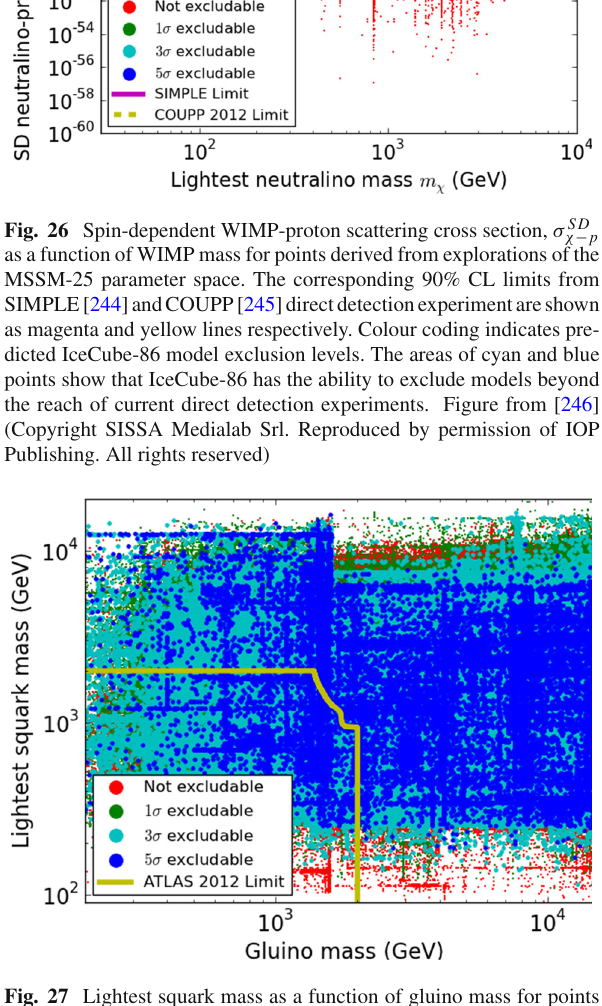
Fig. 27 Lightest squark mass as a function of gluino mass for points derivedfromexplorationsoftheMSSM-25parameterspace.Thepoints to the bottom left of the magenta line are excluded by ATLAS at 95% CL, based on searches for direct production of coloured sparticles and their decay into jets and missing transverse energy. Colour coding indi- cates predicted IceCube-86 model exclusion levels. Figure from [246] (Copyright SISSA Medialab Srl. Reproduced by permission of IOP Publishing. All rights